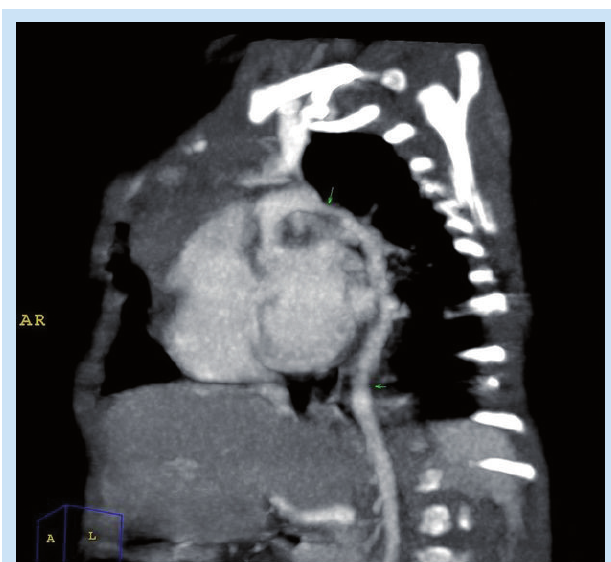
Fig 2. Sagittal maximum intensity projection image (arrows) depicting coarctation of the aorta.